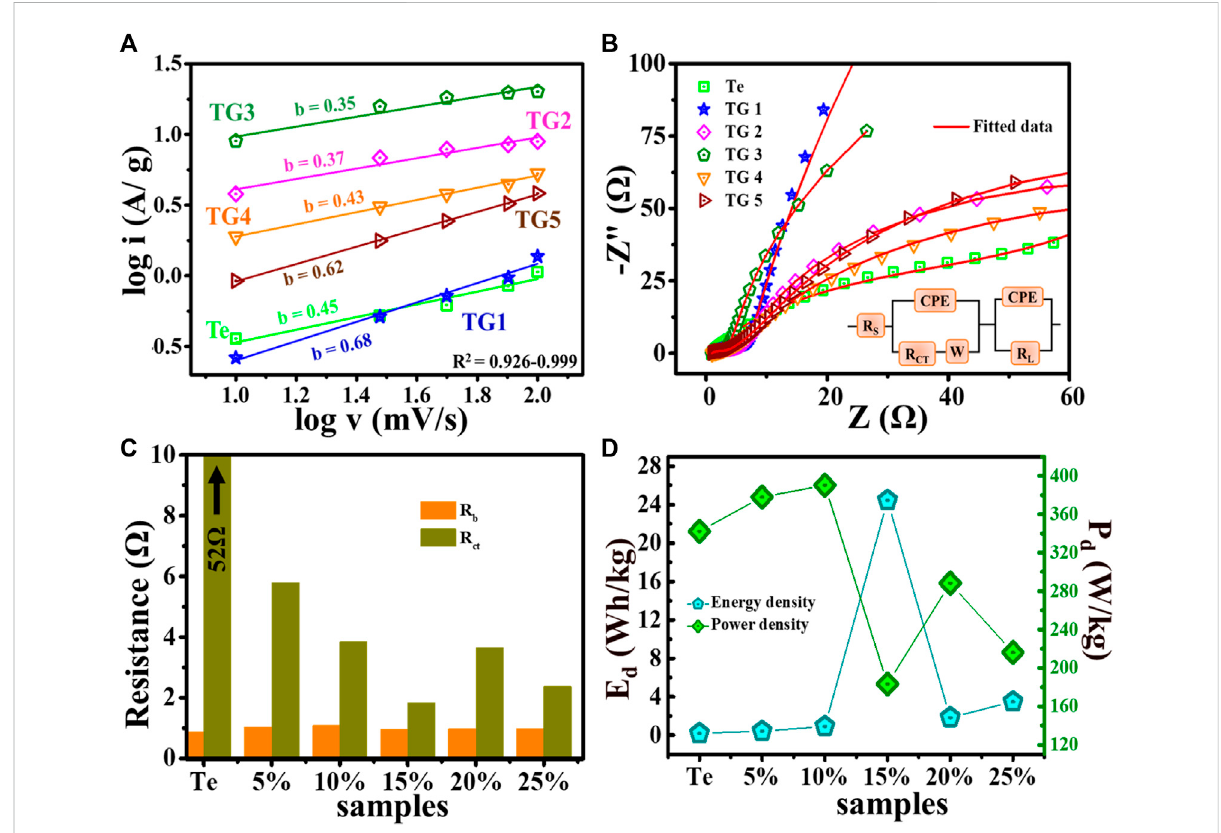
FIGURE 6 (A) log i vs. log v plot, (B) Nyquist plot, (C) variation in R b and R ct , and (D) Calculated energy density and power density @ 1